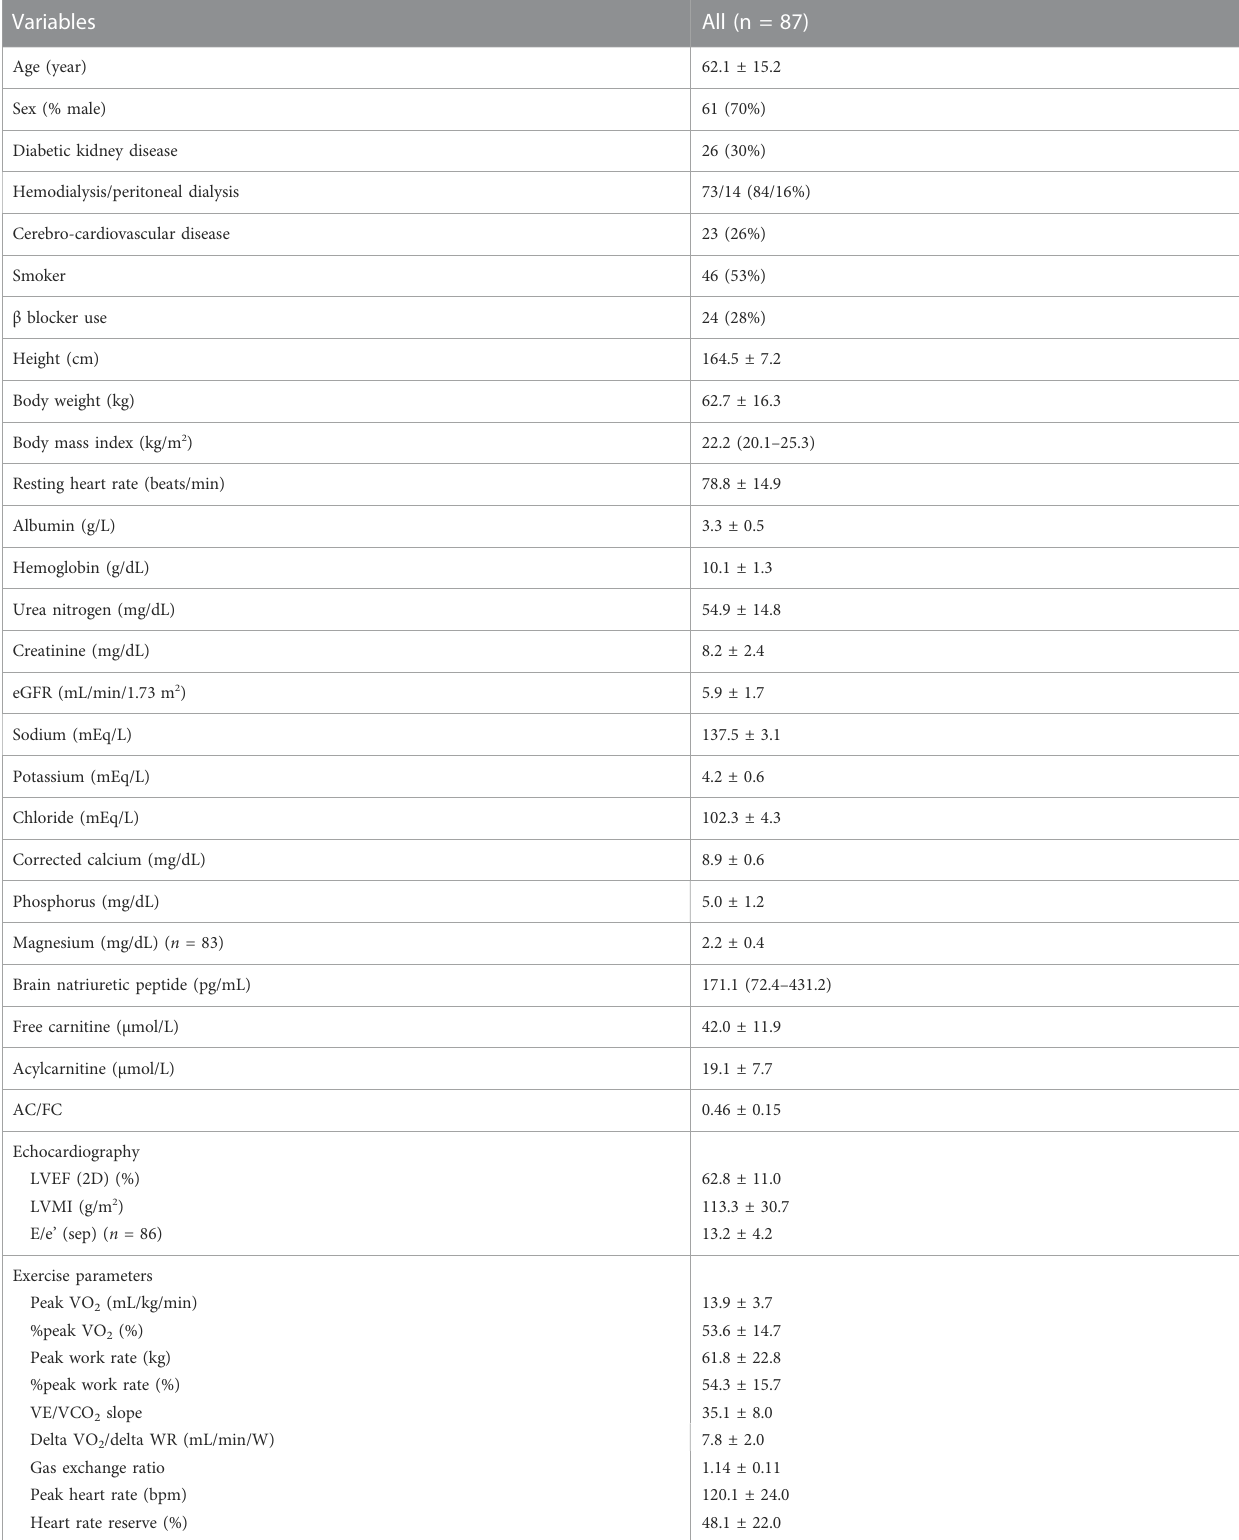
TABLE 1 Background characteristics of the study